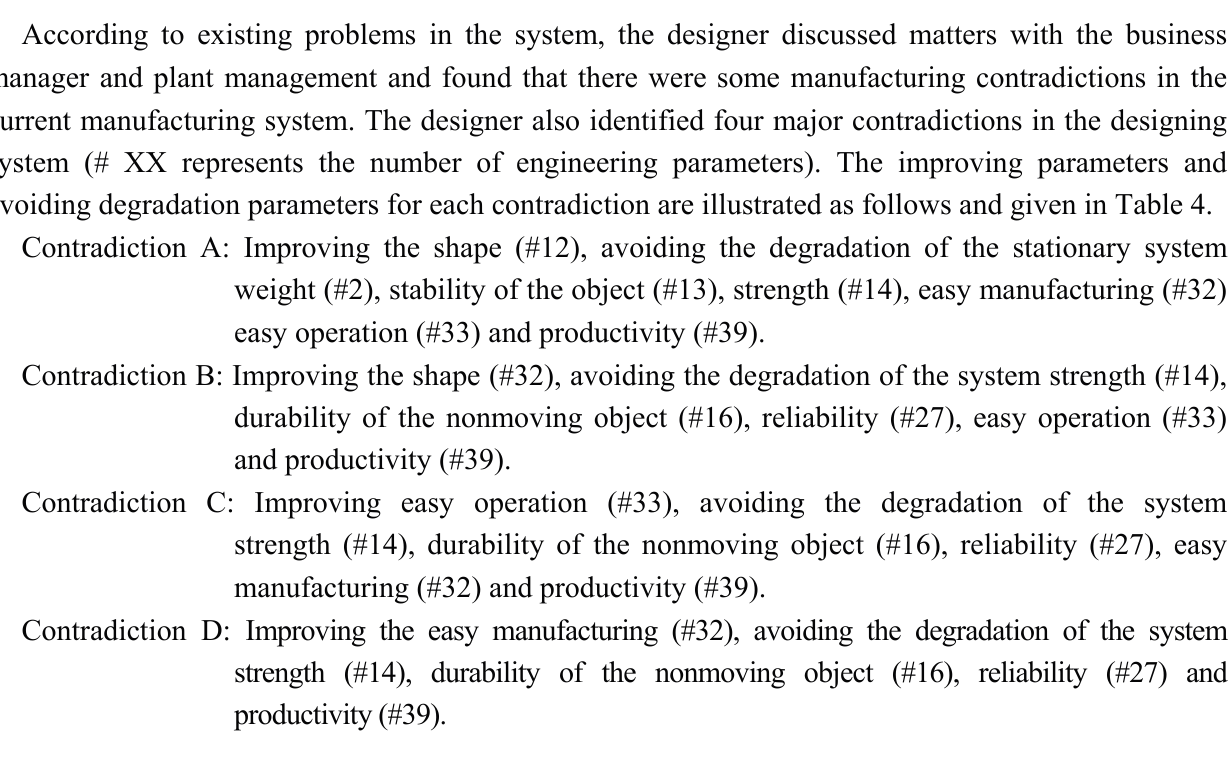
Table 4. Contradiction matrix for this case